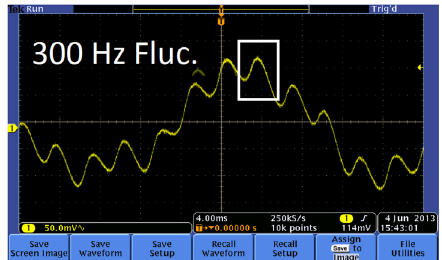
FIG. 15. 300 Hz fluctuation in the power-supply output measured by the